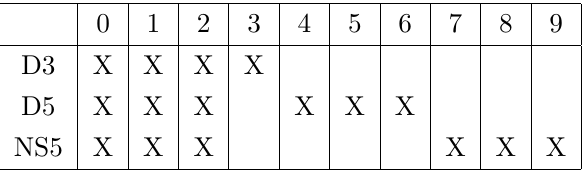
Figure 1 . General linear quiver.